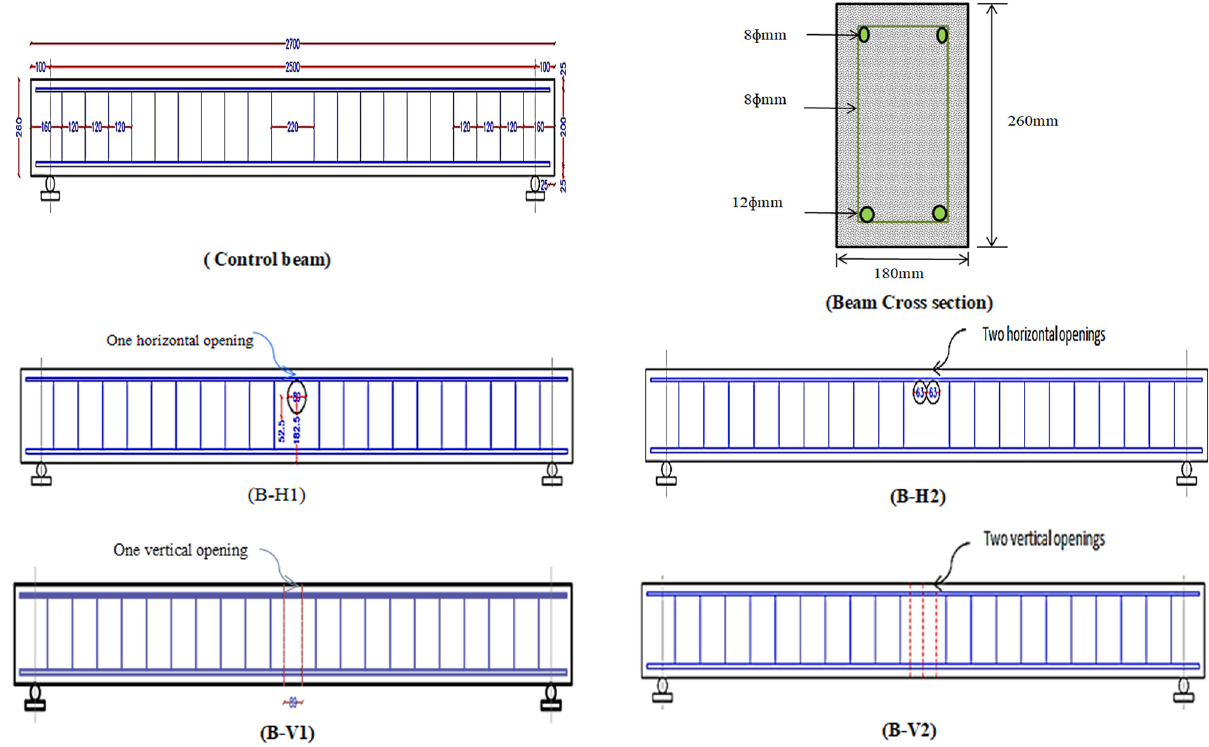
Figure 1: Details of the proposed beams ( all dimensions are in mm )